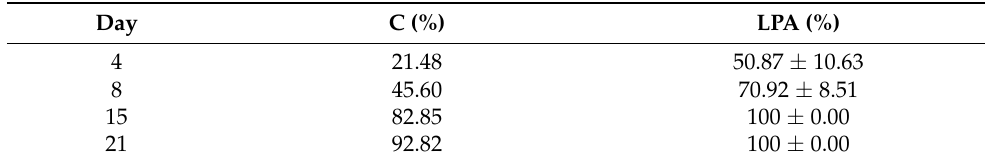
Table 1. Percentage reduction in wound size during the healing